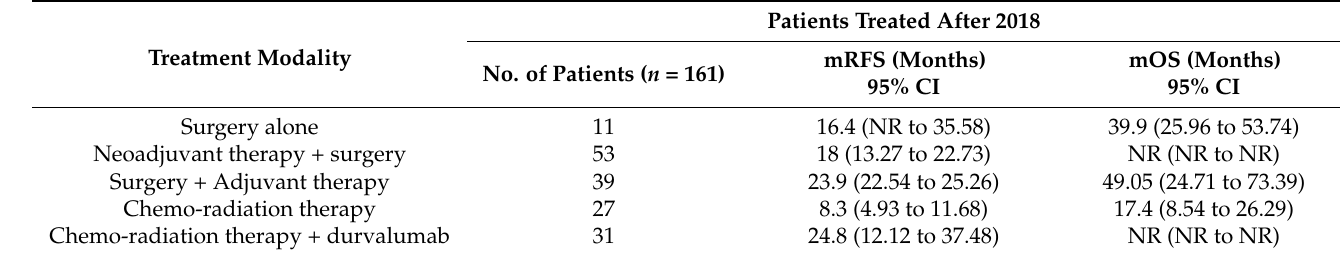
Table 5. Survival outcomes as per initial therapy in patients treated after